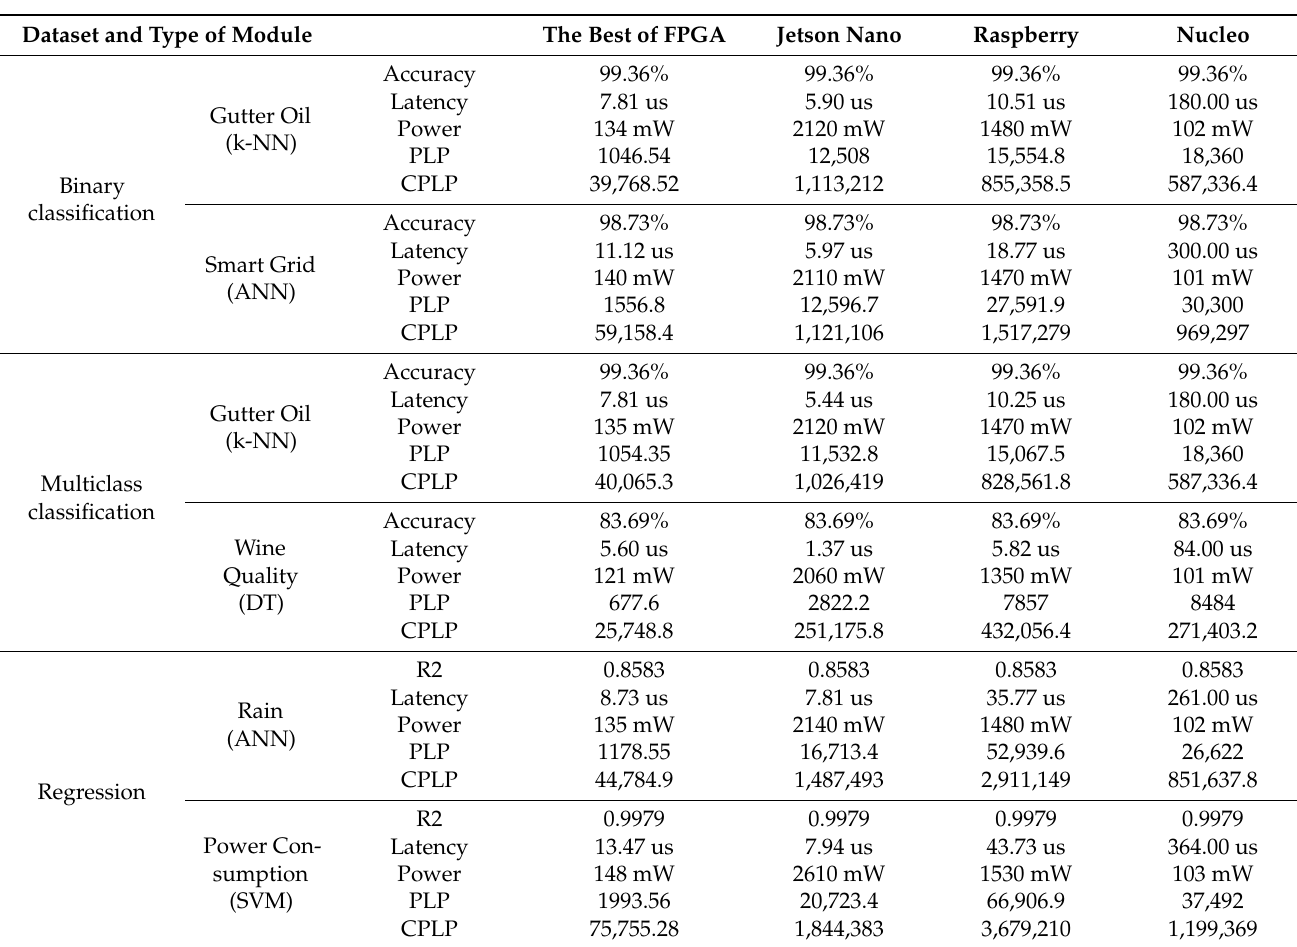
Table 17. Breakdown of platform implemented